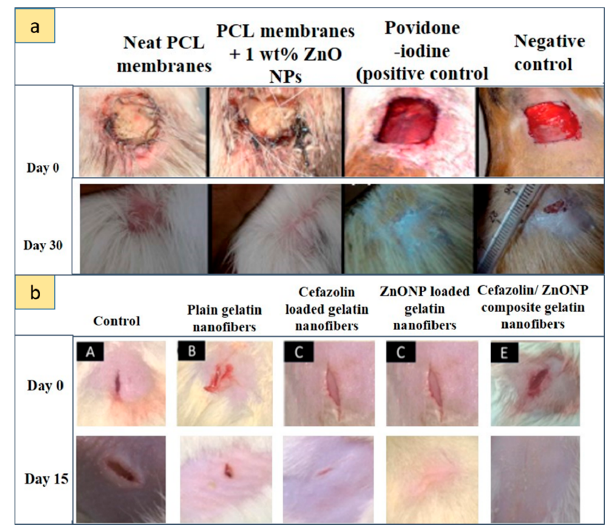
Figure 7. Results of different wound-healing dressing solutions in vivo. ( a ) Wound-healing activity of the membrane. The first column indicates neat PCL membranes, the second column indicates a PCL membrane incorporated with 1 wt.% ZnO NPs, the third column indicates povidone–iodine-treated wounds (positive controls), and the fourth column indicates negative controls. ( b ) Physical estimation of wound healing at various time intervals in the control (A), plain gelatin nanofibers (B), cefazolin-loaded gelatin nanofibers (C), ZnO NP-loaded gelatin nanofibers (D), and cefazolin / ZnO NP composite gelatin nanofibers (E) (adapted from [109], with permission from RSC, 2019, and from [112], with permission from Elsevier, Table 3 . Main results of recent studies on ZnO-based nanomaterials and electrospun ZnO–polymeric hybrid nanomaterials for wound-healing applications .